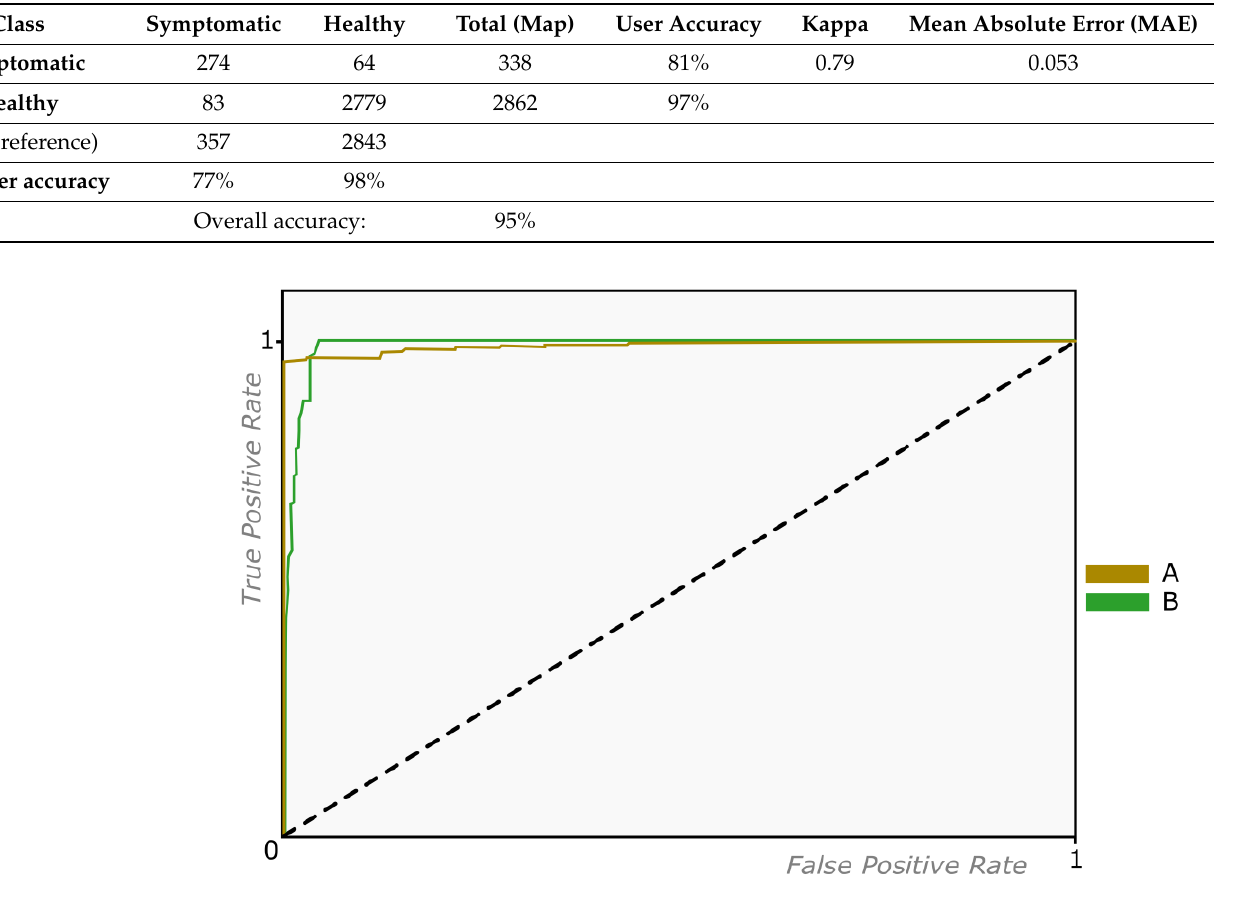
Figure 7. Receiving Operator Characteristics (ROC) curves for each class (A: declining; B: healthy).